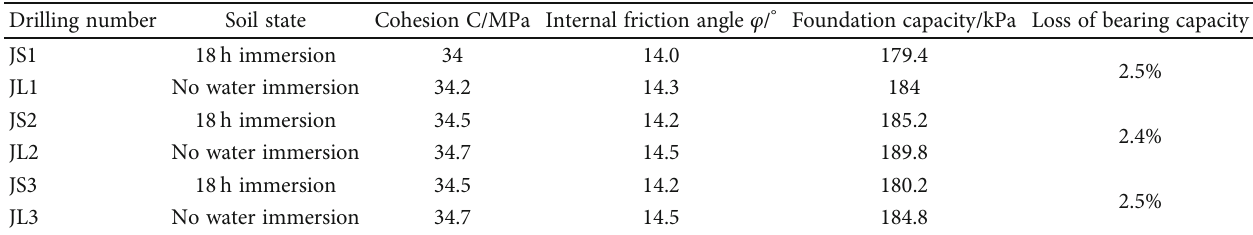
Table 6: Backcalculation of shear strength index bearing capacity of soil before and after immersion. Drilling